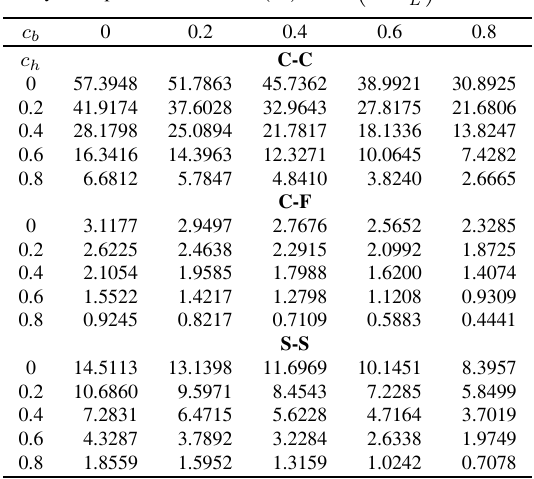
Table 2 Non-dimensional critical load ( λ = P cr L 2 /E 0 I 0 ) for an